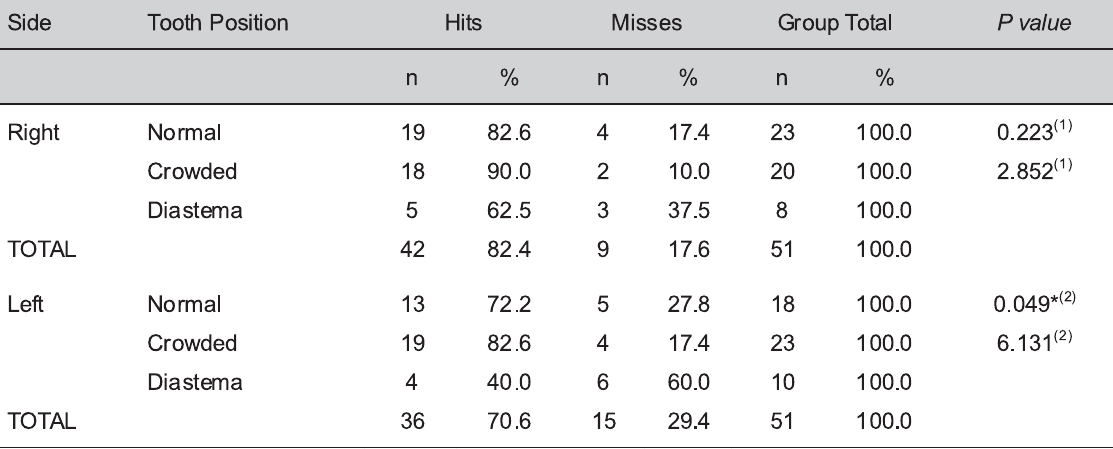
Table 2 - Distribution of hits and misses for normal tooth position, crowded teeth and teeth with diastema, according to hemiarch, in the mandibular arch of the study subjects. João Pessoa, Brazil,